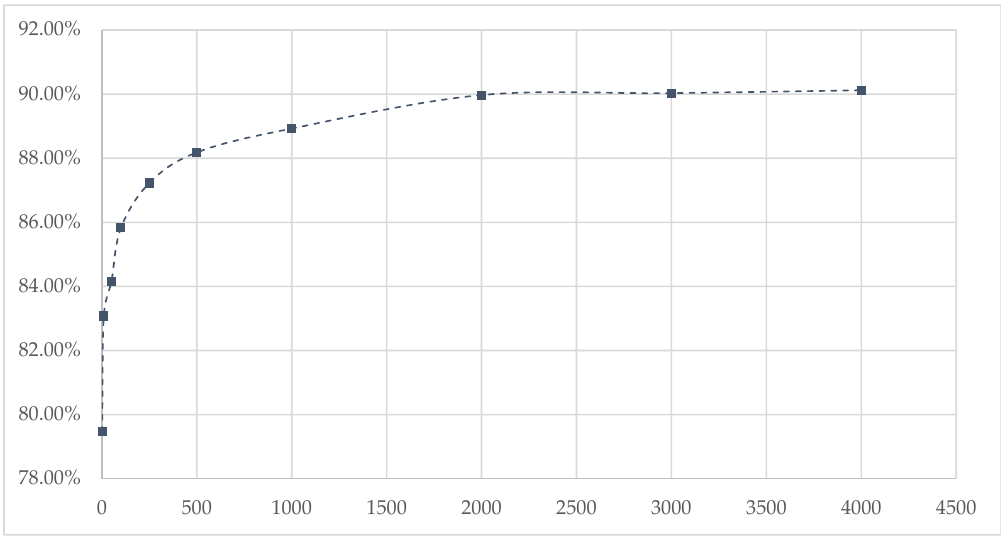
Figure 6. C value selection graph for Support Vector Machines (SVM) plotted against the overall accuracy of the scene.